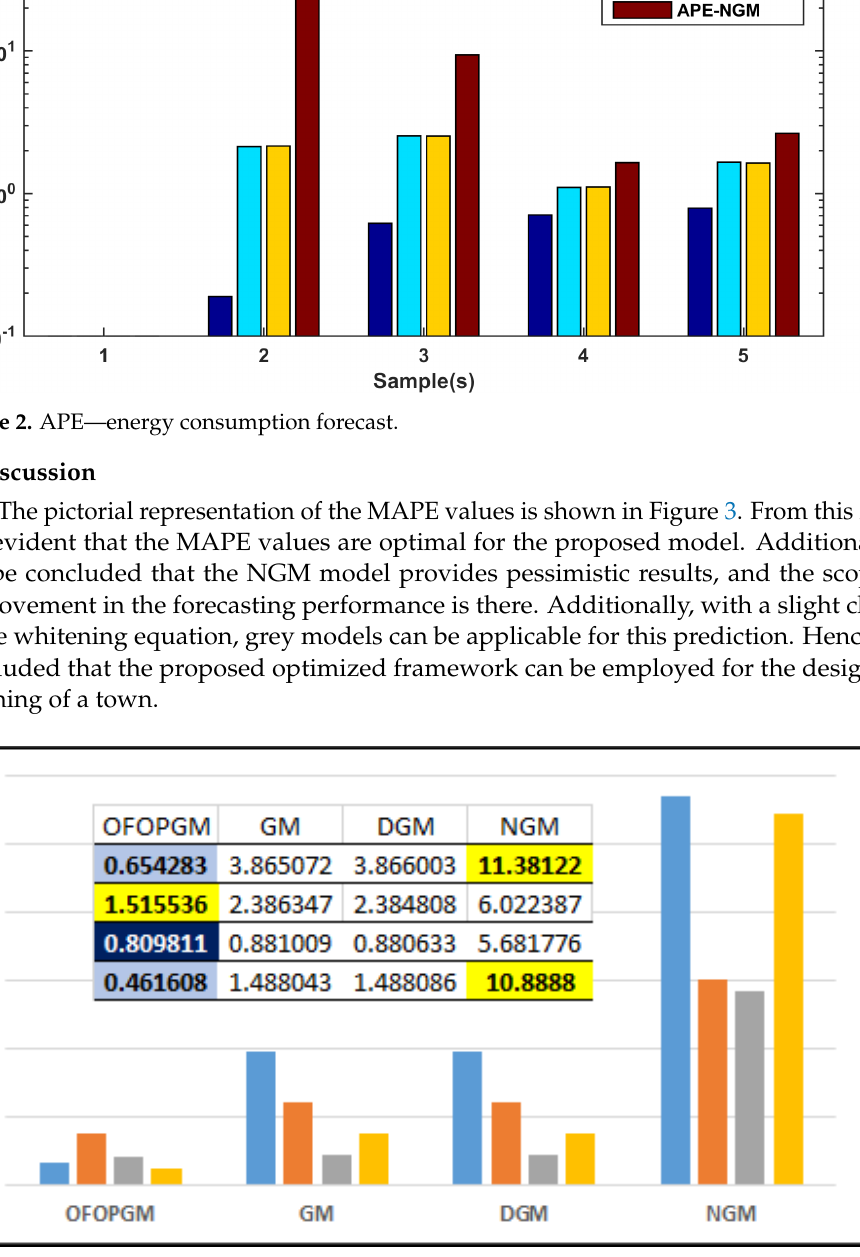
Figure 3. MAPE values of different test cases (case 1–case